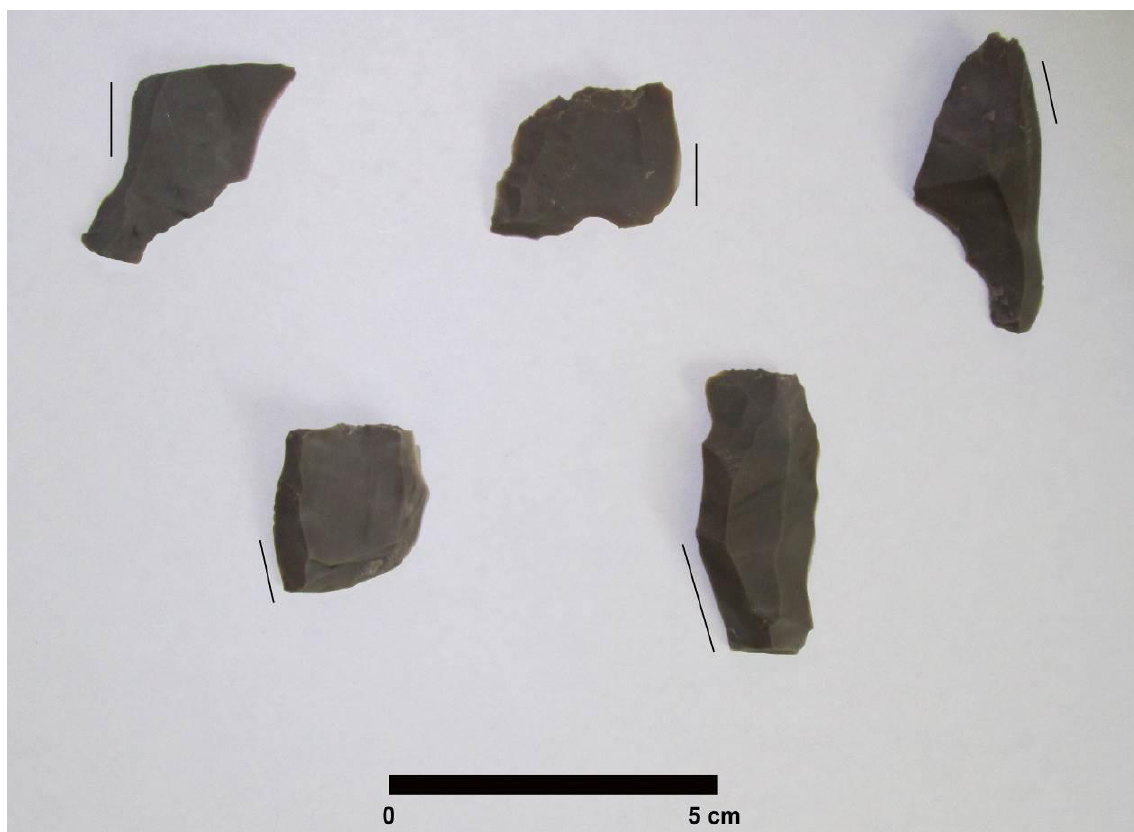
Figure 2: The experimental MUG flake scrapers with utilized edges